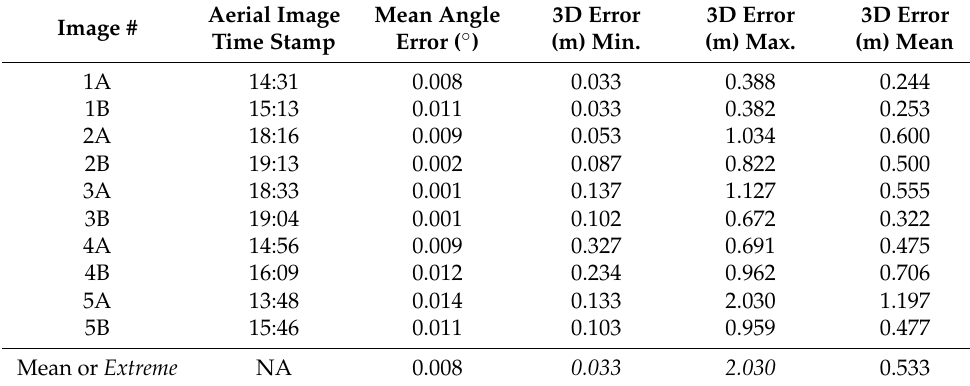
Table 3. The GCP errors for each georeferenced wildfire